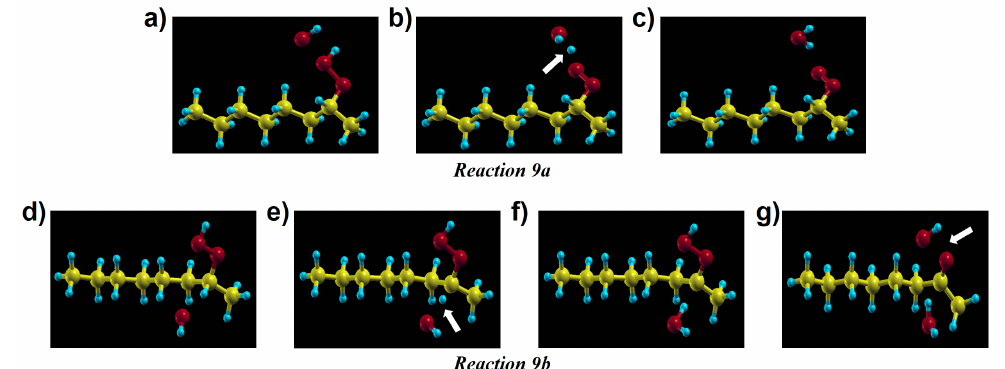
Figure 12. Intermediate steps of reactions 9a (panels ( a – c )) and 9b (panels ( d – g )) of Figure 2, showing two possible channels of hydroperoxide decomposition due to the action of a hydroxyl radical in a molecular model. The different outcome of the two reactions stems from the initial position of the hydroxyl relative to the hydroperoxide